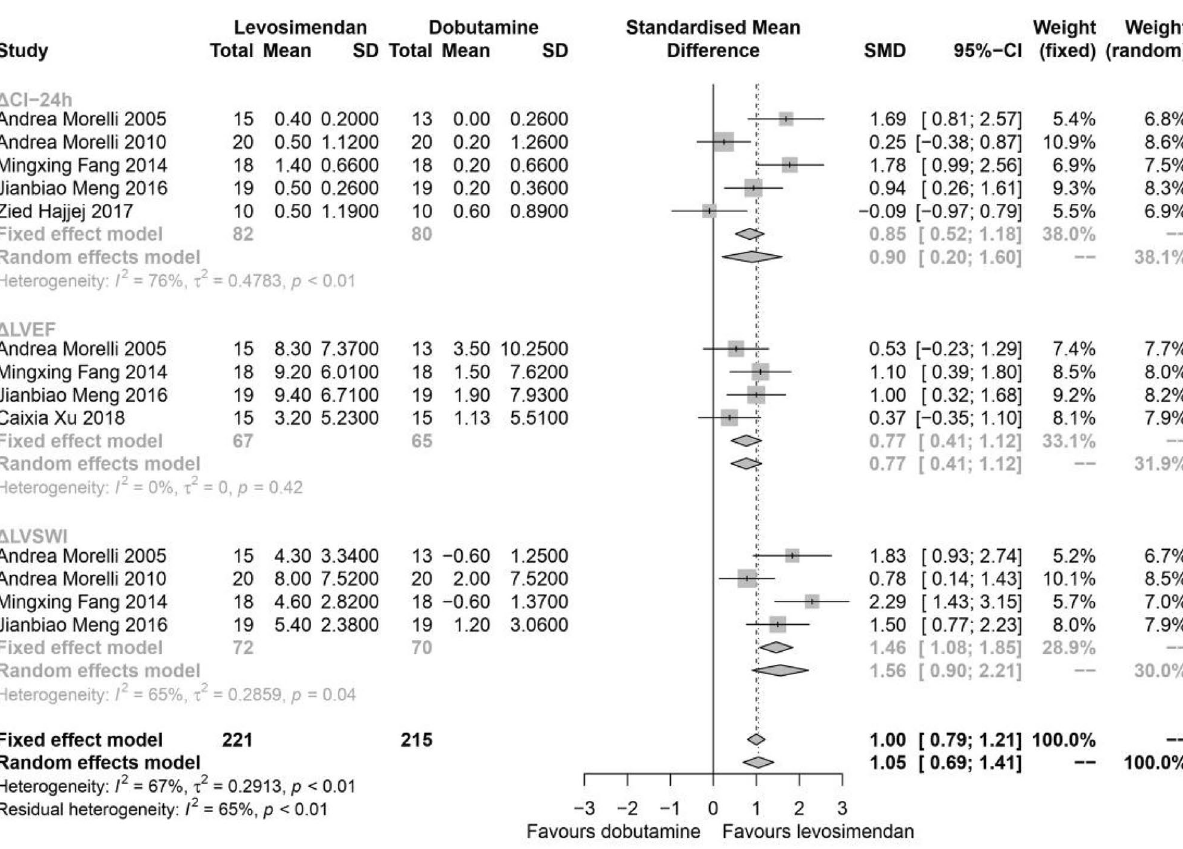
Figure 3. Change (before-after comparison to the baseline) of cardiac function at the time point of 24-h. ΔCI- 24 h: the change (before-after comparison to the baseline) of cardiac index at the time point of 24-h; ΔLVEF: the change (before-after comparison to the baseline) of left ventricular ejection fractions at the time point of 24-h; ΔLVSWI: the change (before-after comparison to the baseline) of left ventricular stroke work index at the time point of 24-h; SD standard deviation; MD mean difference; CI confidence